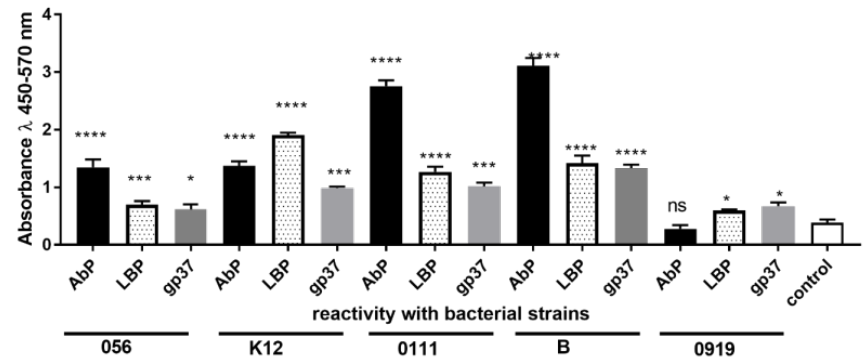
Figure 5. The reactivity in the ELISA test of lipopolysaccharide binding protein (LBP), adhesin gp37 (gp37), polyclonal anti-Escherichia coli antibody (AbP) with Escherichia coli strains: 056, K12, 0111, B, and Lactobacillus rhamnosus LOCK 0919 (919). Pooled results from three independent experiments are shown. *, P < 0.05; ***, P < 0.001; ****, P < 0.0001; ns., non-significant.